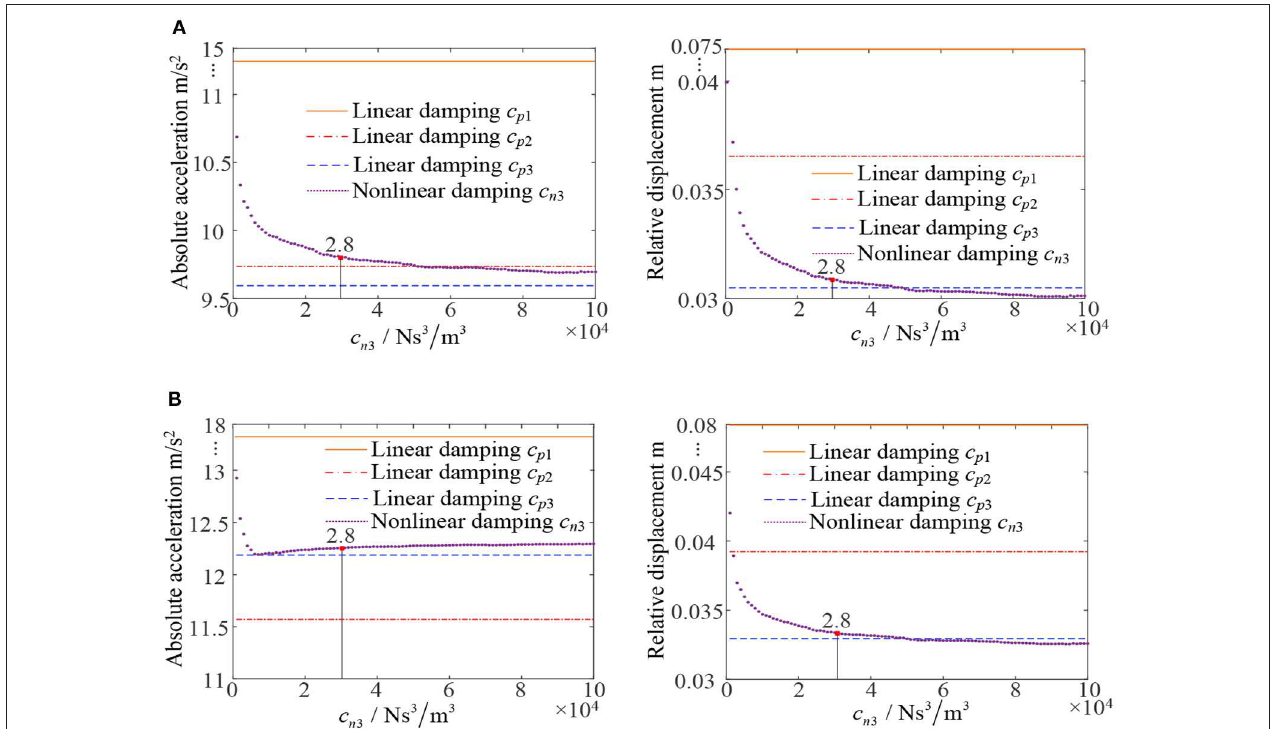
FIGURE 11 | Maximum output acceleration and inter-story drift under Type 2 ground motion. (A) Absolute acceleration and inter-story drift of the first floor. (B) Absolute acceleration and inter-story drift of the second